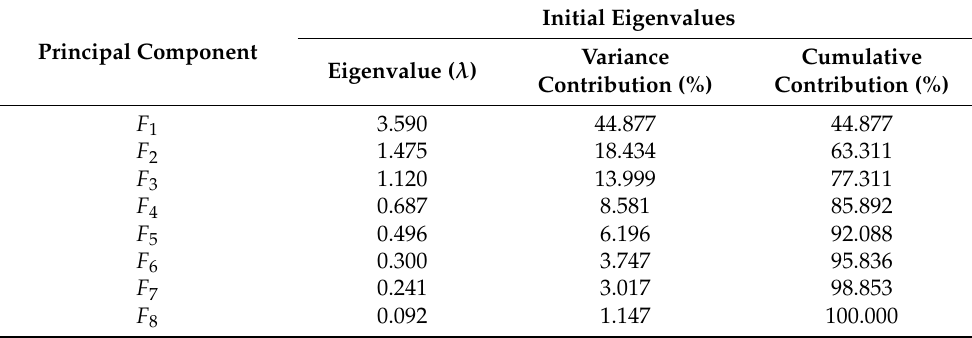
Table 3. Eigenvalues and cumulative contribution rates of principal